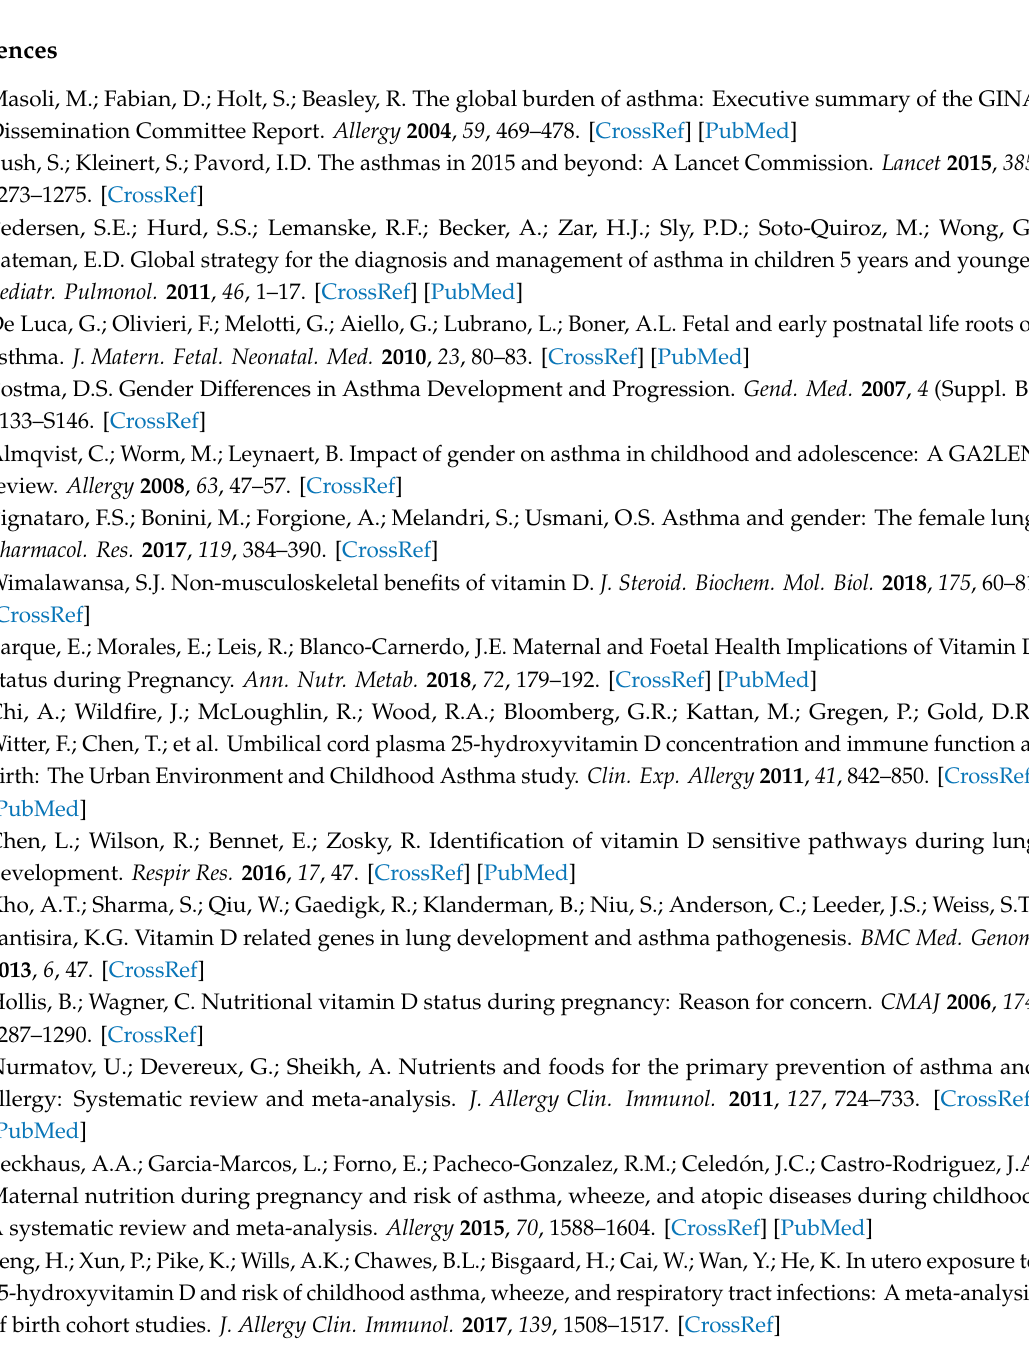
Table S1: Characteristics of the study population in numbers and